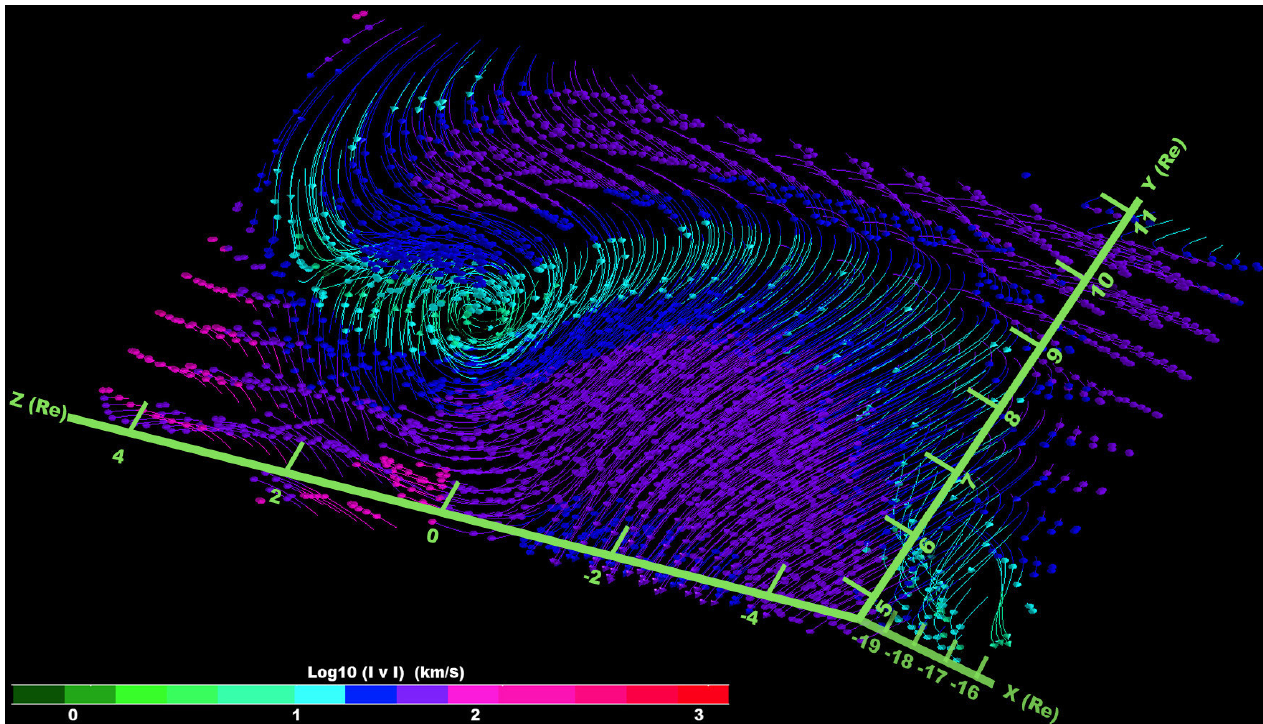
Fig. 4. Dusk nightside vortex that shows how some vortices could be rotating on the x axis and then twisting into another